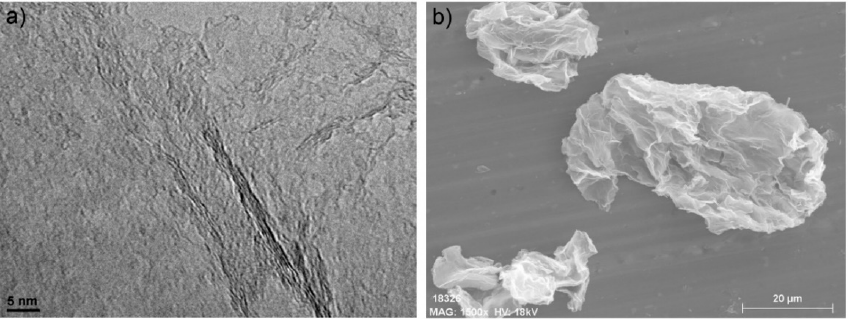
Figure 4. ( a ) TEM image obtained from typical rGO flakes and ( b ) SEM representative image obtained from GLYMO-rGO flakes.